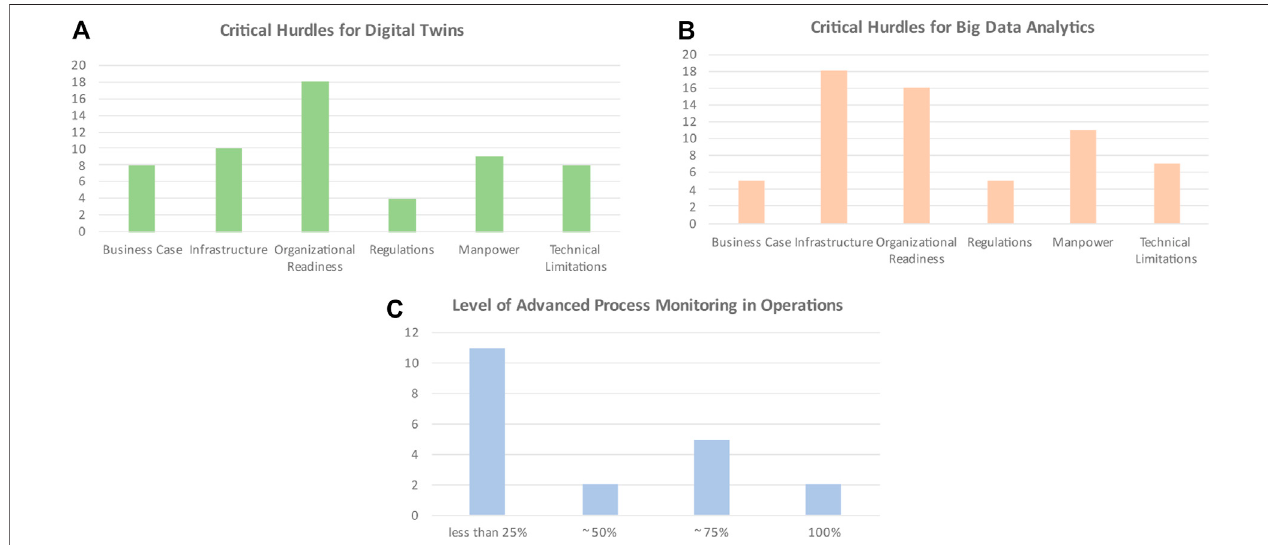
FIGURE 6 | Critical hurdles in implementing digitalization concepts; (A) illustrates the hurdles identi fi ed for implementing Digital Twins in operations, (B) illustrates the hurdles identi fi ed for implementing Big Data analytics in operations, (C) illustrates the current state of advances process monitoring carried out during operations.